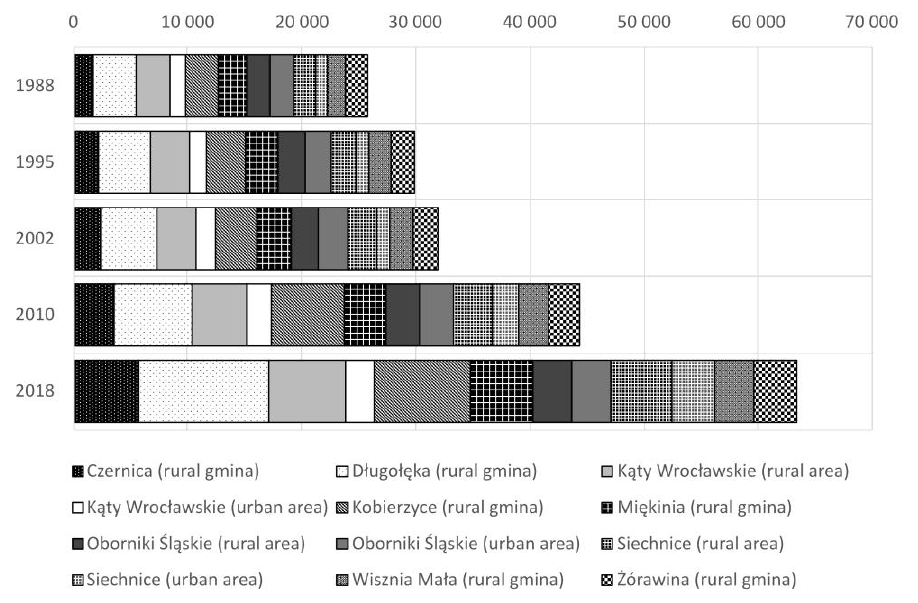
Fig. 6. Number of dwellings in communes in the suburban zone of Wrocław (1989-2018)